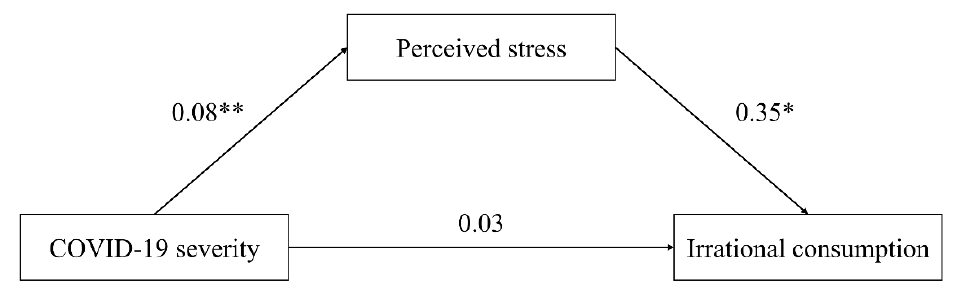
Figure 4. Mediation analysis: perceived stress as a mediator (Study 2). * represents significance at the 0.05 level; ** represents significance at the 0.01 level.